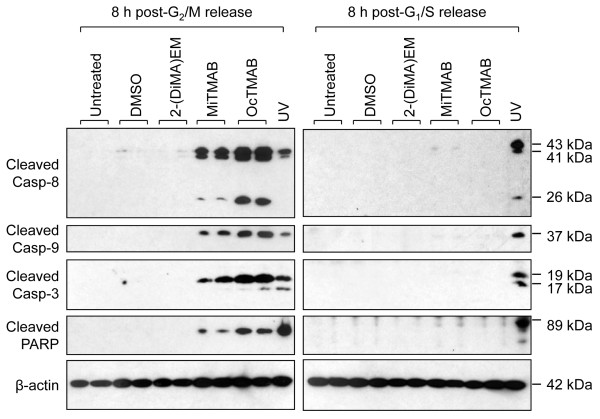
MiTMABs induce caspase activation specifically in cells undergoing mitosis. G2/M and G1/S synchronized cells were treated for 8 h with 10 µM MiTMAB, 10 µM OcTMAB or indicated controls (untreated, 0.1% DMSO and 10 µM 2-(DiMA)EM). The lysates (prepared in duplicate) were immunoblotted for cleaved caspase-8, -9, -3 and PARP. These cleaved products were observed in cells treated with MiTMABs that had been synchronized at the G2/M, but not the G1/S boundary. Lysates prepared from cells exposed to UV served as a positive control. β-actin levels were used as a loading control.